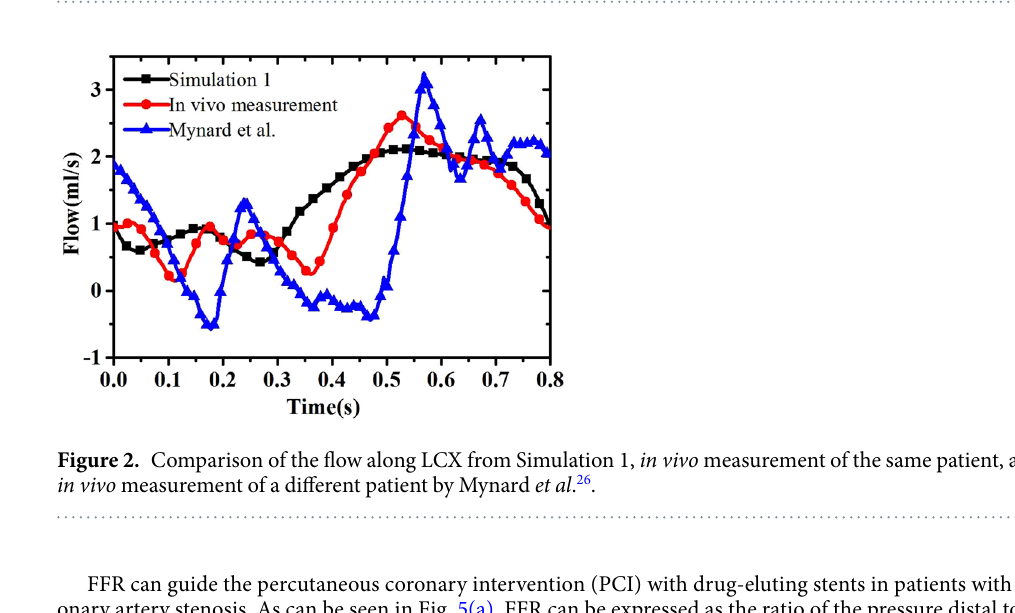
FFR can guide the percutaneous coronary intervention (PCI) with drug-eluting stents in patients with cor- onary artery stenosis. As can be seen in Fig. 5(a), FFR can be expressed as the ratio of the pressure distal to the lesion ( p d ) and the pressure ( p a ) proximal to the lesion 25 :